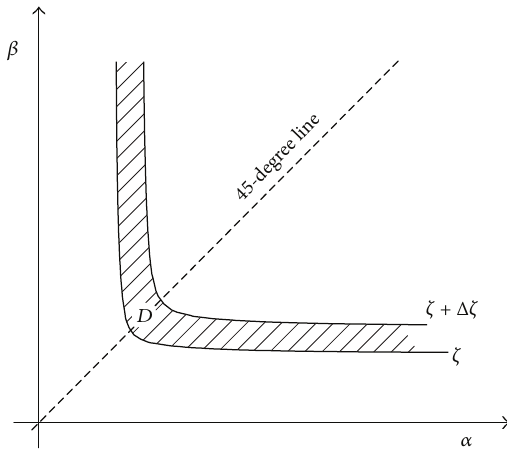
Figure 11: Domain 𝐷 between two isopower curves over which a double integration is to be carried out.